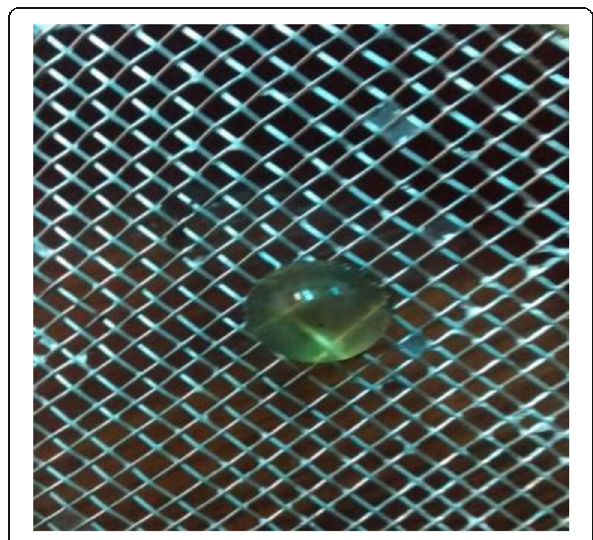
Fig. 13 Group IV (cataract treated with 300 μ g/ml of ethanolic extract)